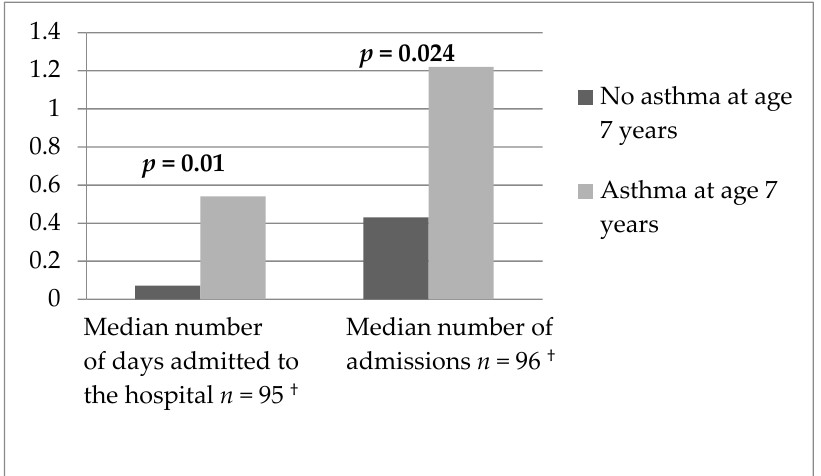
Figure 3. Number of days hospitalized for respiratory difficulties and number of admissions during the year following inclusion in the study. Data collected at the first annual follow-up. † Number of cases in the